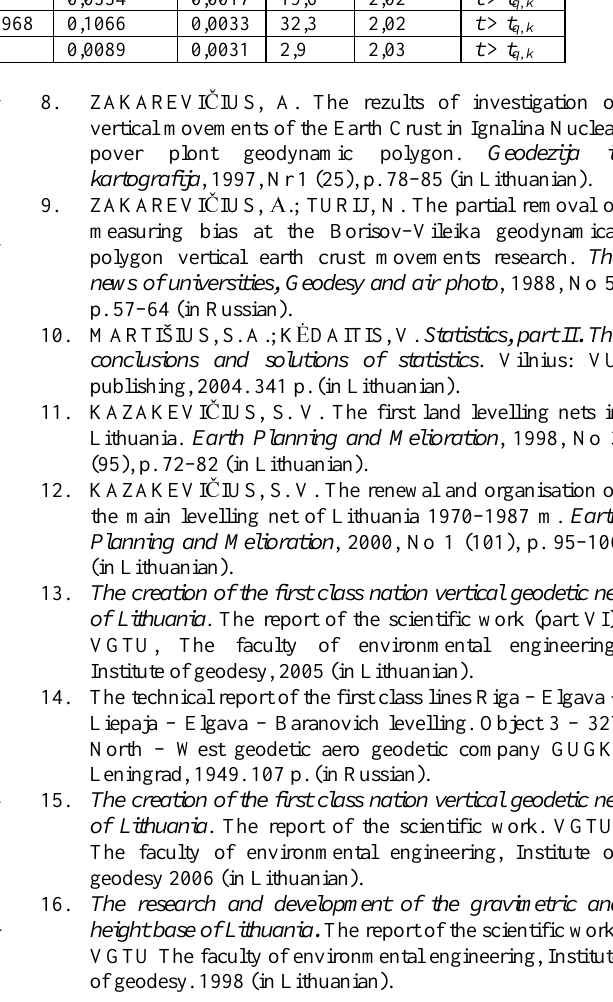
∆ ∆σ σ Pastabos ( ) t t q , k ( q = 0,05) 0,0184 0,0013 14,2 2,08 0,0197 0,0016 12,3